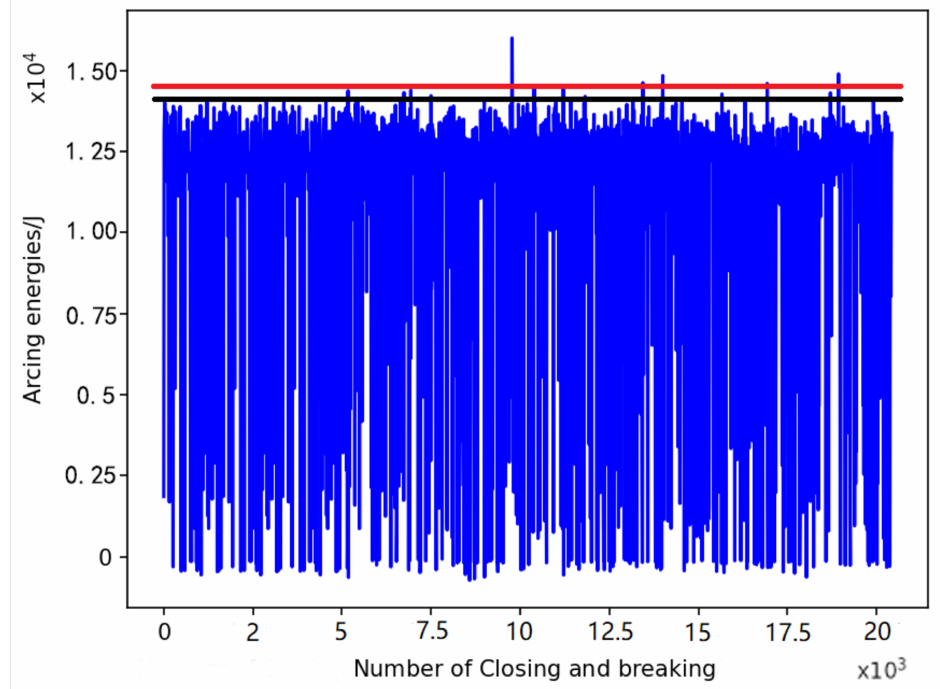
Figure 6. Arc ignition energy corresponding to closing and